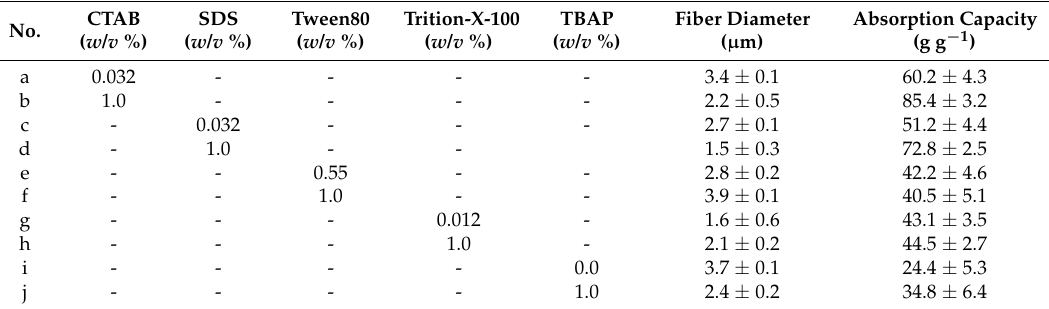
Table 2. Relationship of solution compositions and the characteristics of as-spun